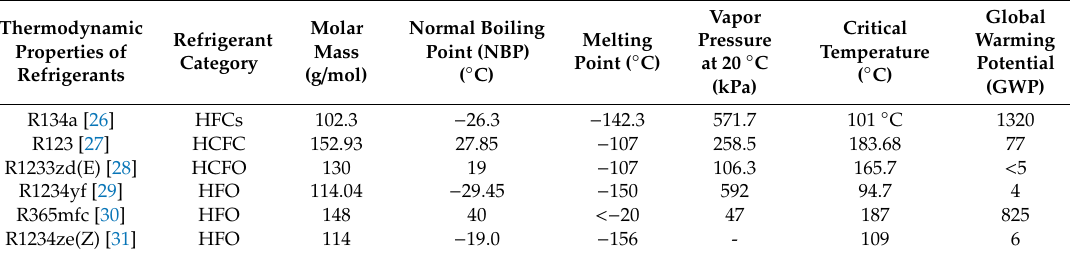
Table 1. Thermo-physical properties of